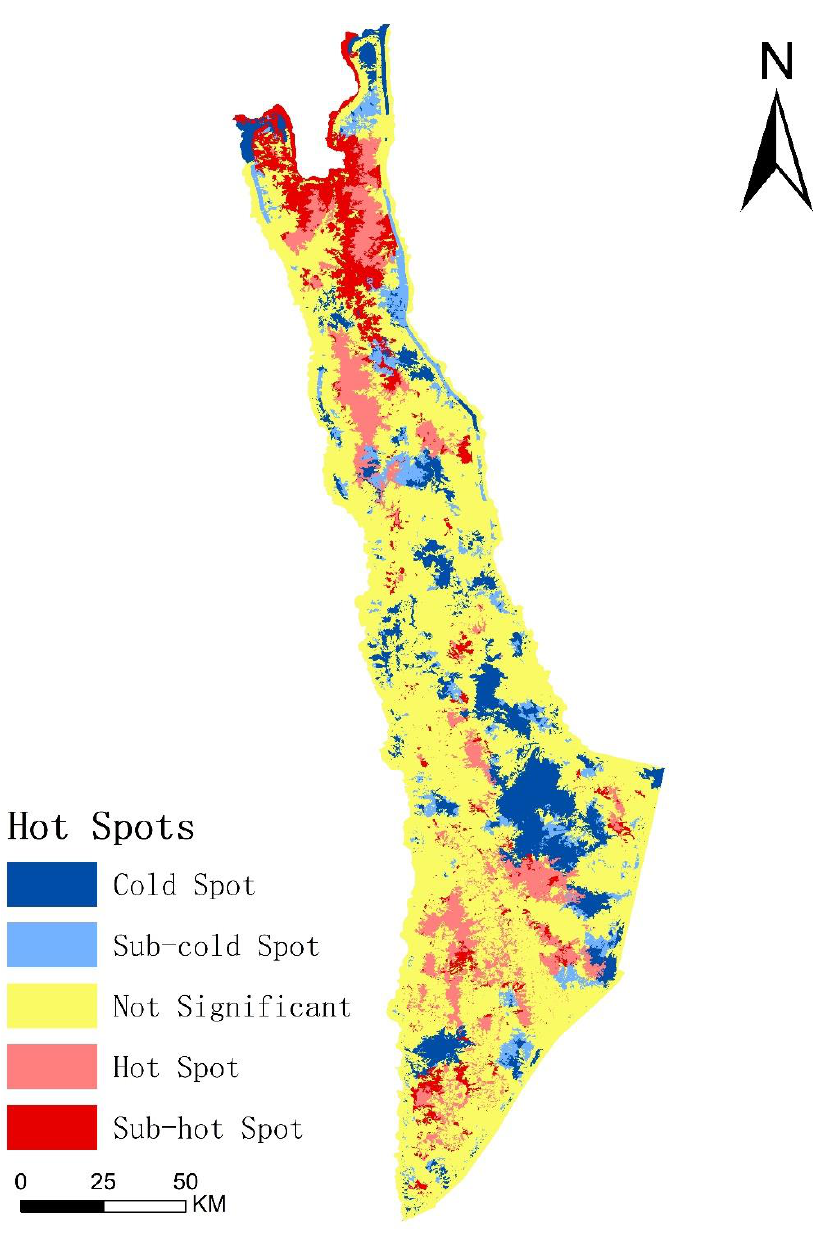
Figure 5. Hot spot analysis map of habitat quality in 2018.